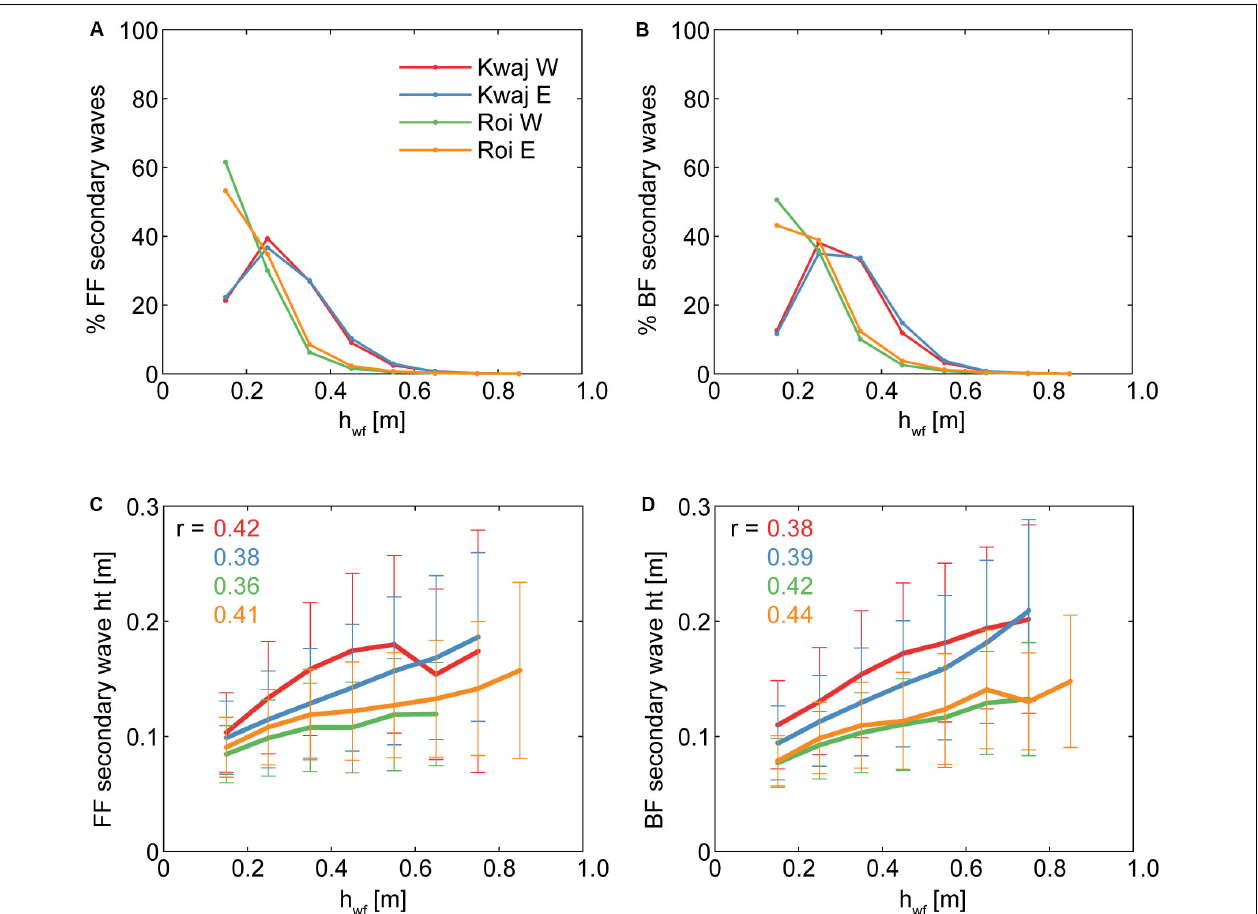
FIGURE 6 | The effects of infragravity (“IG”) waves on the prevalence and heights of secondary short-period waves at the inner reef flat for the four sites with the largest IG waves. For all panels, the colors correspond to sites in (A) , and reef-flat water levels were constrained to a 0.1 m window (0.5 < h reef < 0.6 m). The % of all secondary waves that occurred at different heights along the IG waveform, h wf (see Figure 2A ), for (A) the front face (“FF”) and (B) the back face (“BF”) of the IG waves. The mean ± one standard deviation of the secondary wave heights according to h wf for (C) the FF and (D) the BF of the IG waves, with correlation coefficient, r , given for each site. The lower portions of the IG waves have the greatest number of secondary SS waves, but the largest ones occur higher up on the IG wave, independent of overall reef-flat water levels.